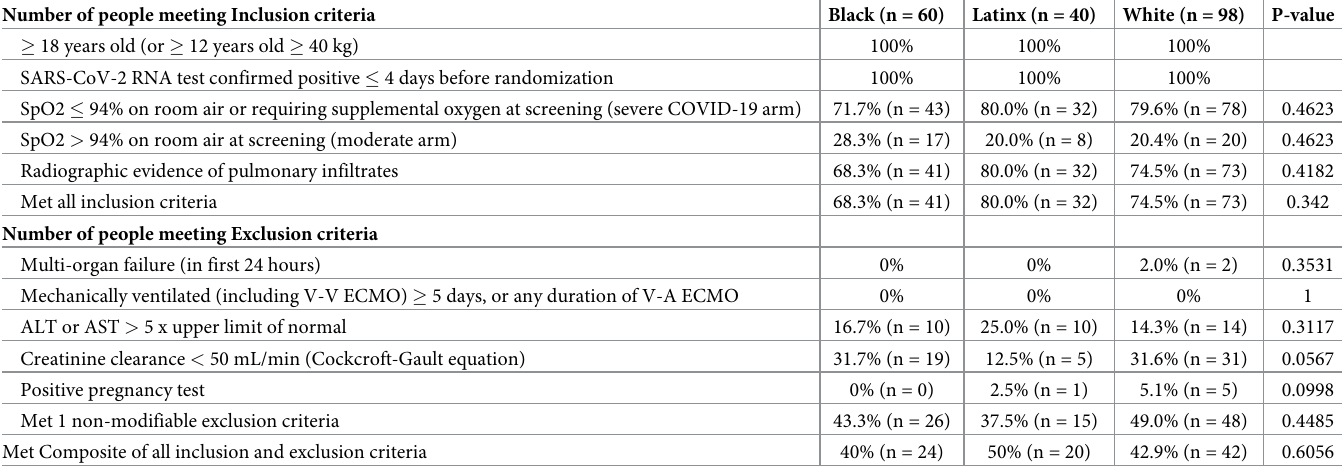
Table 2. Study participants and eligibility criteria for